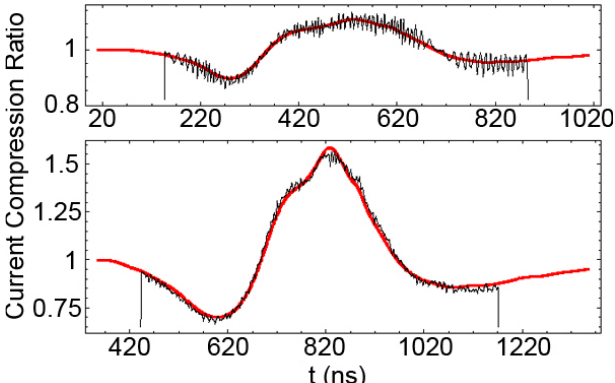
FIG. 4. (Color) Longitudinal compression ratio I (cid:4) t (cid:5) =I laboratory frame. Top: PIC simulation (black) and fluid model (red) at Z (cid:8) (cid:1) 8 cm , just beyond the acceleration gap. Bottom: PIC simulation (black) and fluid model (red) at Z (cid:8) (cid:2) 29 cm